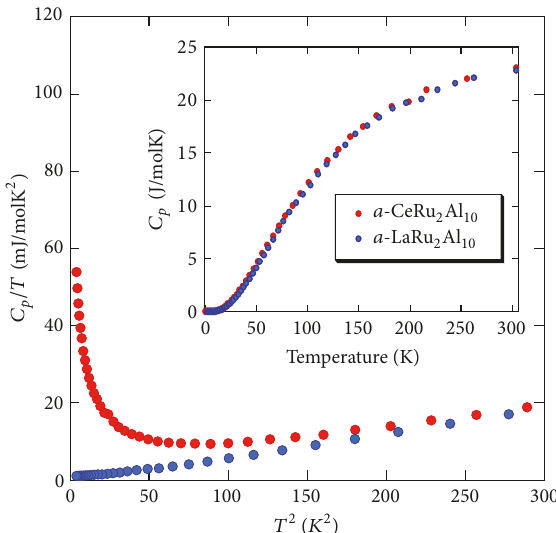
Figure 4: 𝐶 𝑝 /𝑇 versus 𝑇 2 plot for a -CeRu 2 Al 10 and a -LaRu 2 Al 10 alloys. The inset shows the temperature dependence of the specific heat 𝐶 𝑝 for a -CeRu 2 Al 10 and a -LaRu 2 Al 10